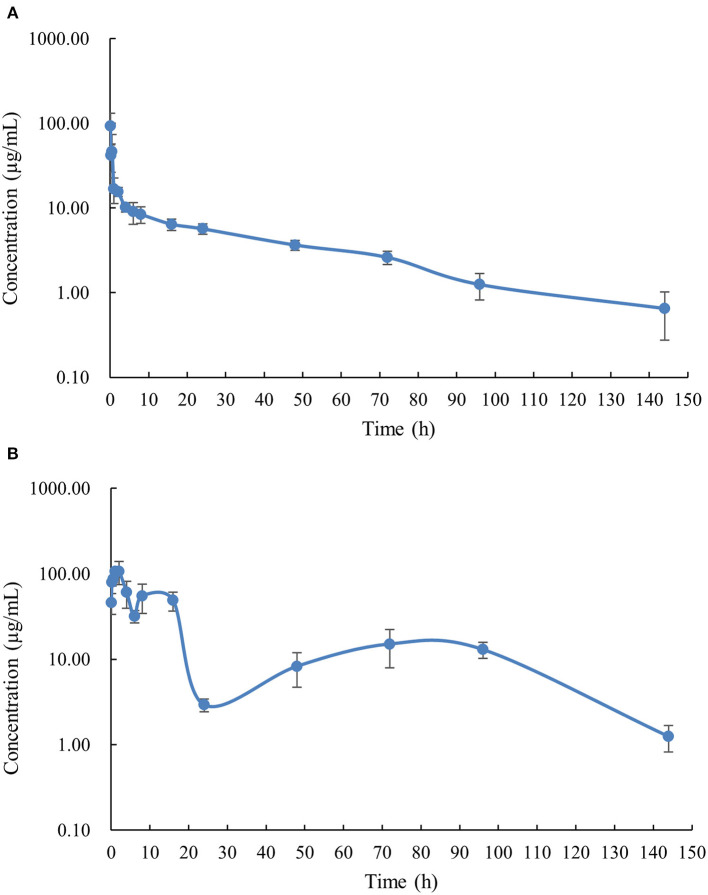
The plasma concentration-time curve with logarithmic scales of doxycycline in channel catfish (Ictalurus punctatus) after intravenous administration at a dose of 5 mg/kg (A) and oral administration at a dose of 50 mg/kg (B).